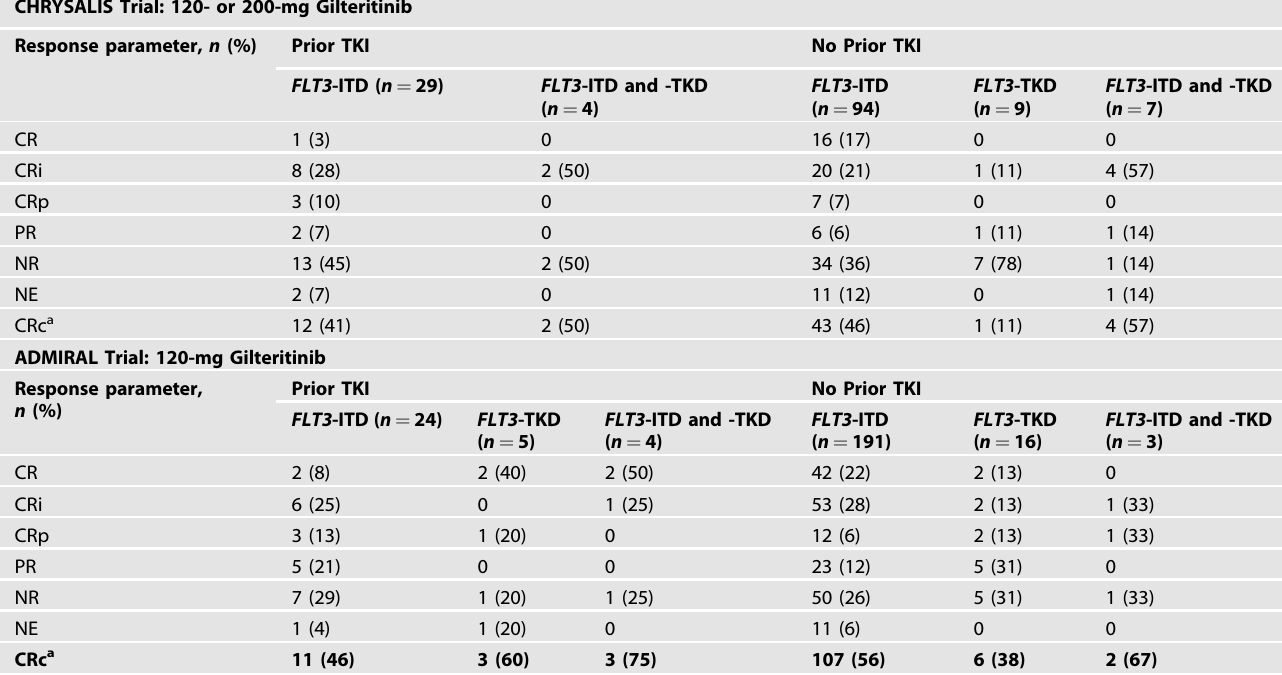
Bold font indicates aggregate responses. a De fi ned as the sum of patients who achieved CR, CRi, and CRc.